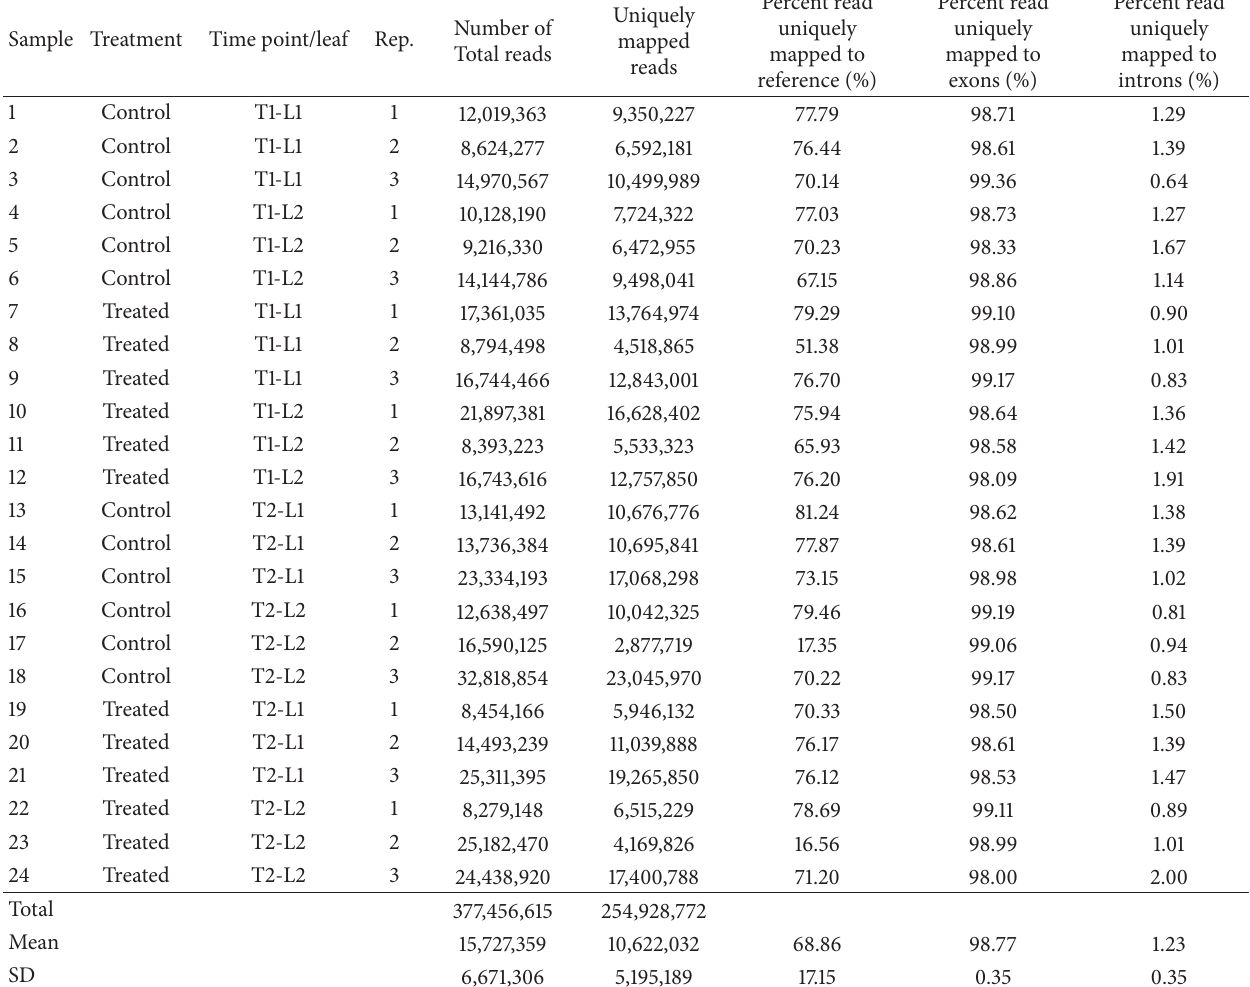
Table 1: Overview of mapping of RNA-seq reads against the reference genome.